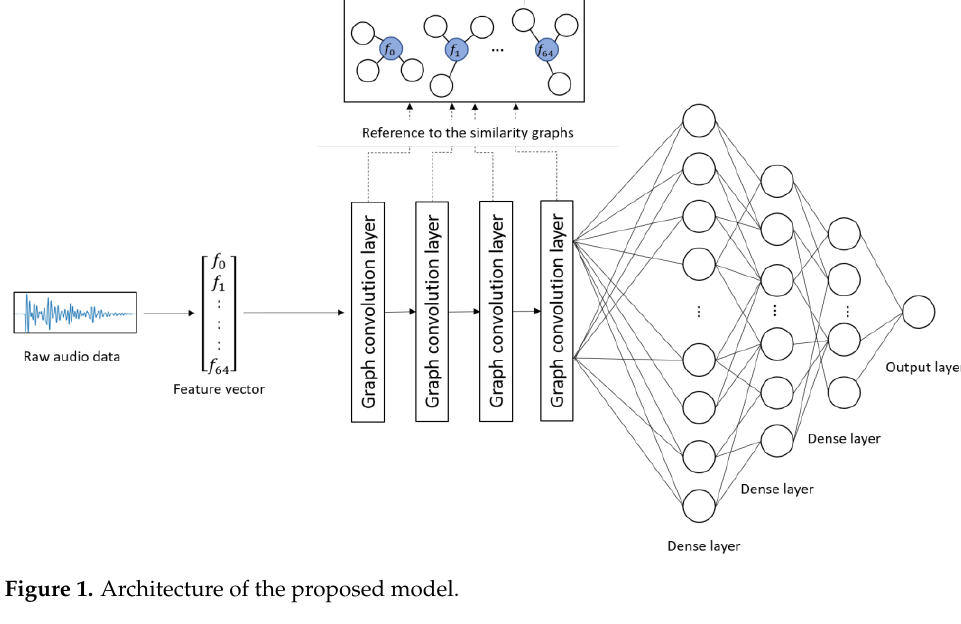
Figure 1. Architecture of the proposed model. Table 2. Details of the architecture of the proposed model.